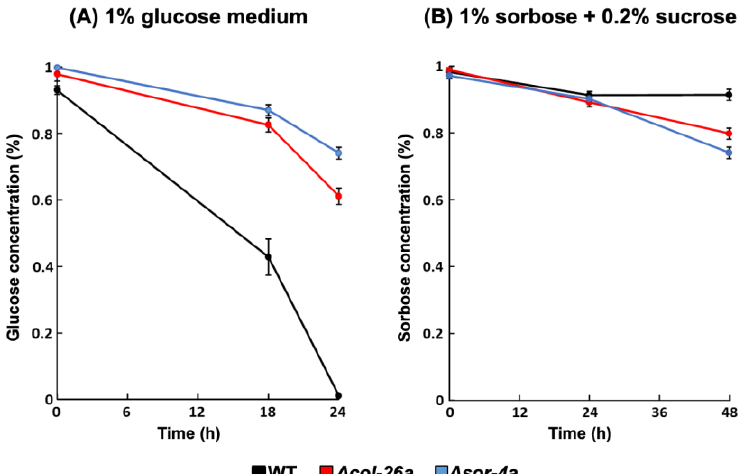
Figure 6. Consumption of glucose or sorbose in sorbose-resistant sor -4 and col -26 mutants. Glucose ( A ) and sorbose ( B ) concentration in the culture medium in the wild type, ∆ col -26 a , and ∆ sor -4 a strains. The concentration of glucose and sorbose in culture filtrate was measured using the F-kit for glucose and the Si – Mo method (see Materials and Methods), respectively. Errors are expressed as the standard error. Three biological replicates were performed.